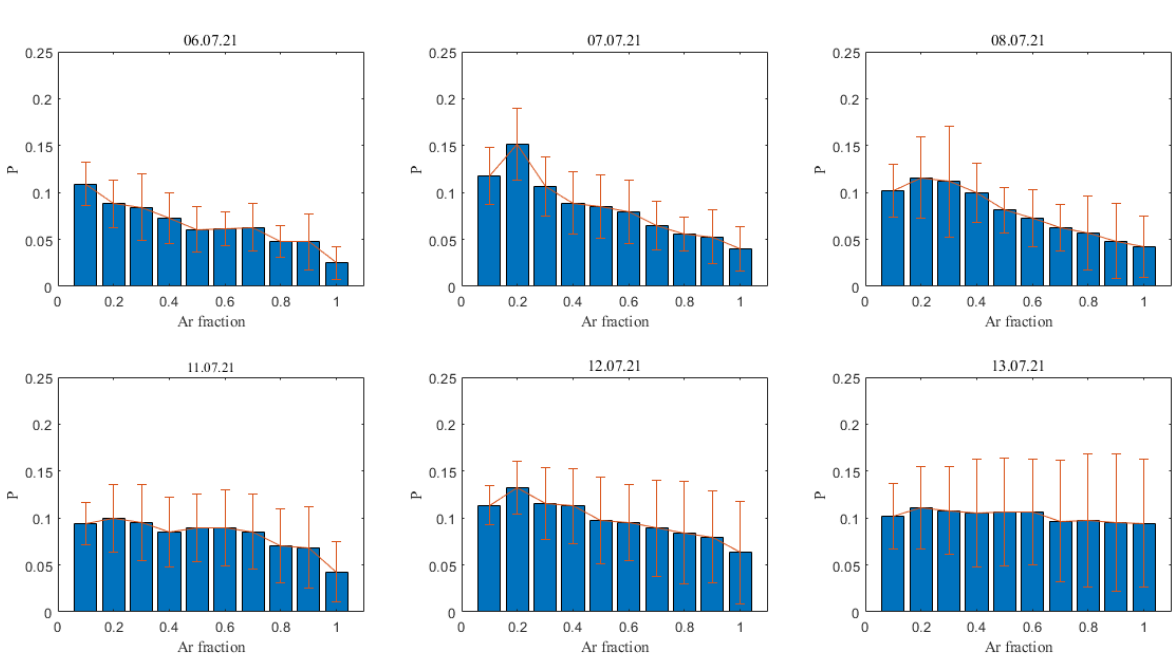
Figure 7 The effect of Amaranthus retroflexus fraction (F) in the pixel on misclassification probability (P) on 6 days of measurements. The mean was calculated based on 5 different sowing plates. Error bars represent the probabilities’ standard deviation.